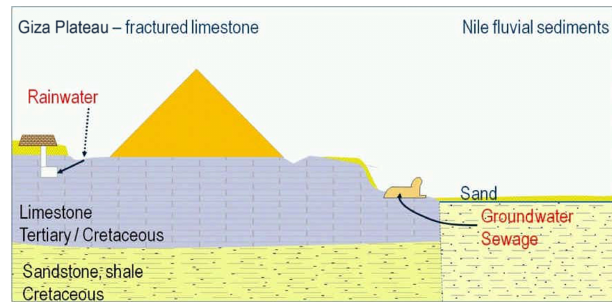
Figure 3. Groundwater aquifers affecting the Giza Plateau (El- Arabi et al.,